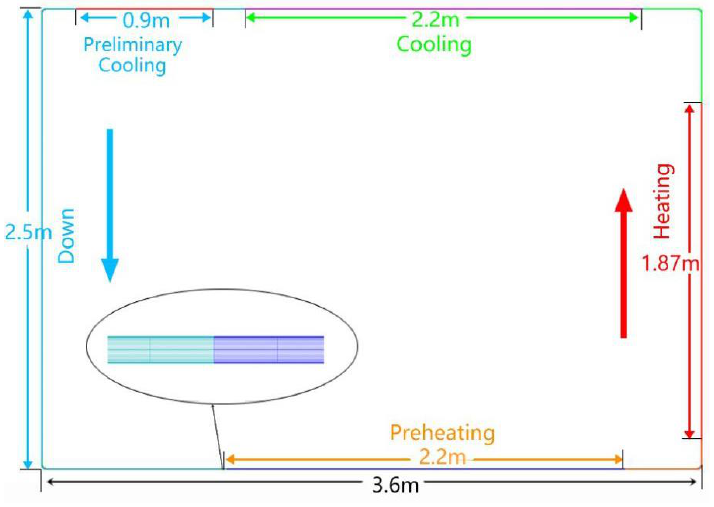
Figure 3. Grid division of supercritical water natural circulation loop.